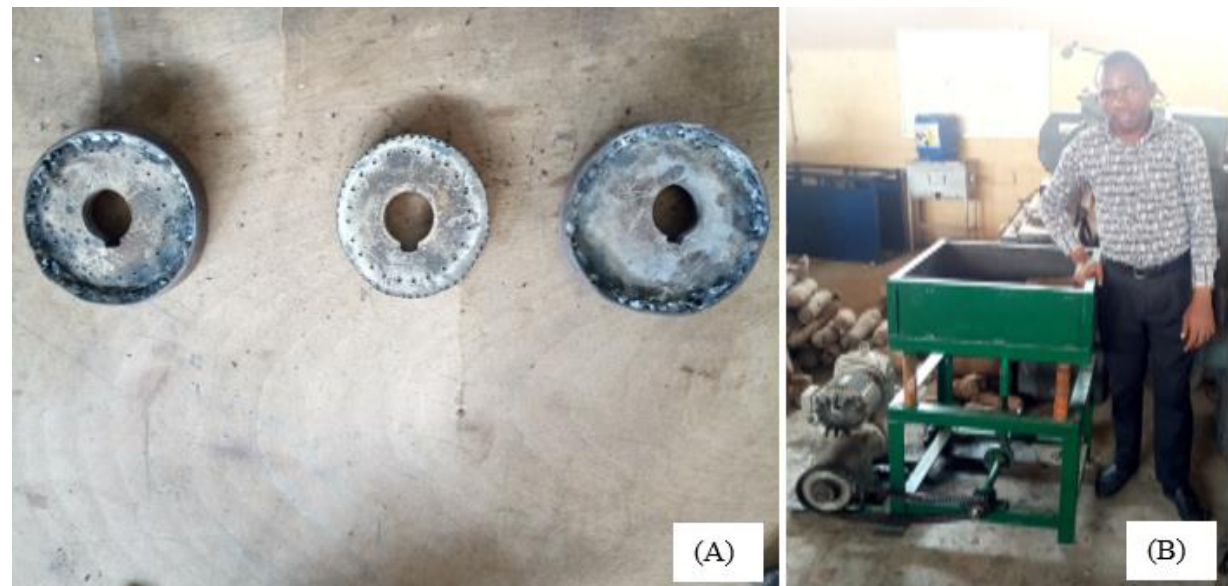
Figure 2. (A) The view of the 10 mm, 5 mm and 20 mm cyFcloid cam size respectively of the developed